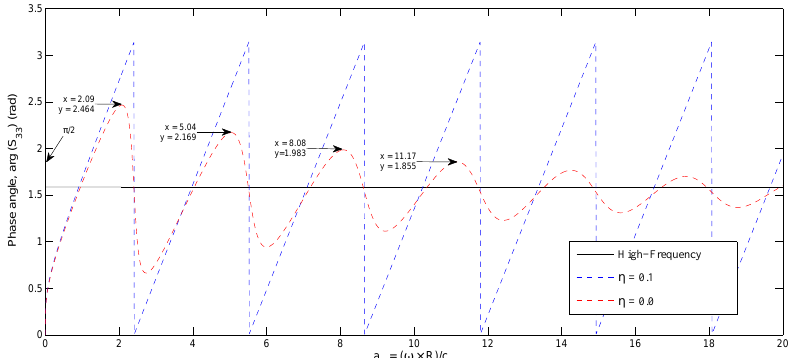
Figure 12. Dynamic stiffness due to high frequency vertical load in the axial direction (continuous line), which is accompanied by the low frequency results (dash lines) with different values of the loss factor when ν = 0.495 and E = 9411 KPa.